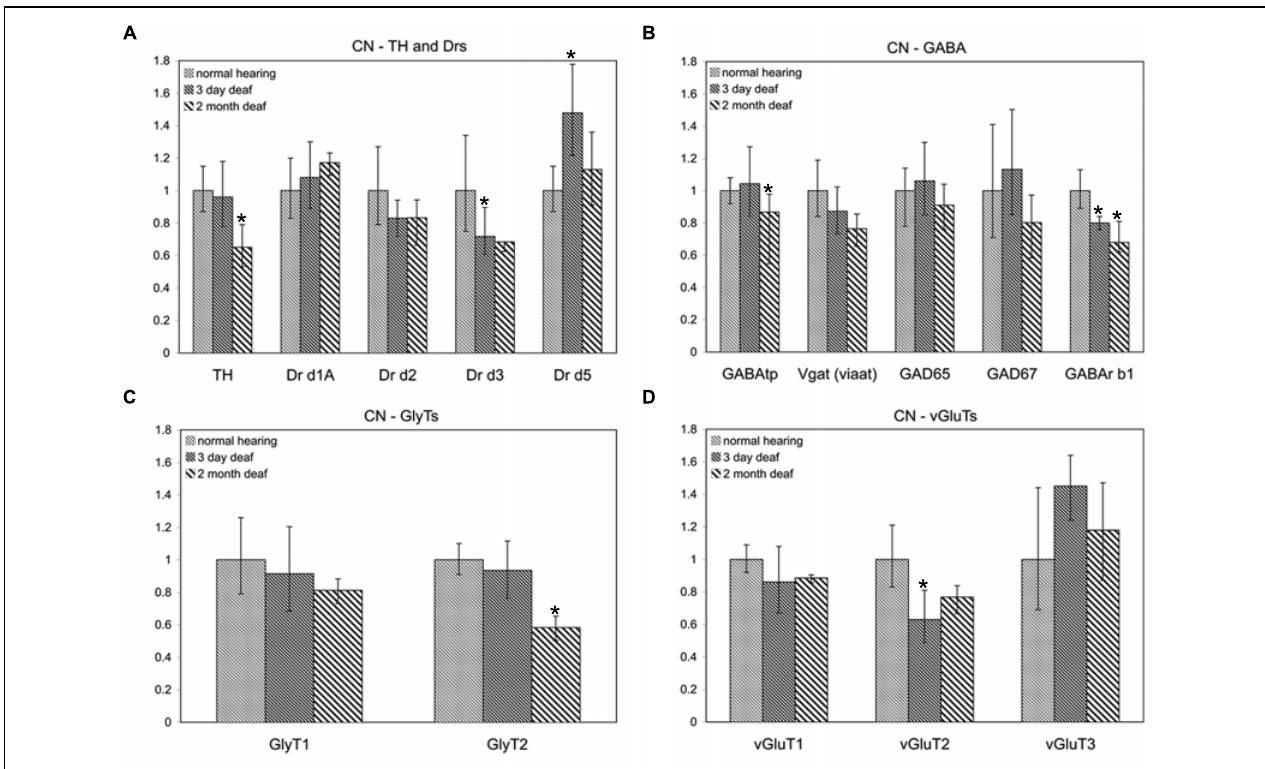
FIGURE 1 | Dopamine (DA) and amino acid neurotransmitter (AAN) related genes are differentially expressed in the cochlear nucleus (CN). Changes were assessed in DA related (A) , inhibitory (B,C) and excitatory (D) AAN related gene expression in the CN, 3 days and 2 months following bilateral cochlear ablation. Although TH gene expression levels were not changed at the 3 day time point, expression was significantly decreased by 2 months (35%; A ). Only two other genes, GABAtp and GLYT2, both